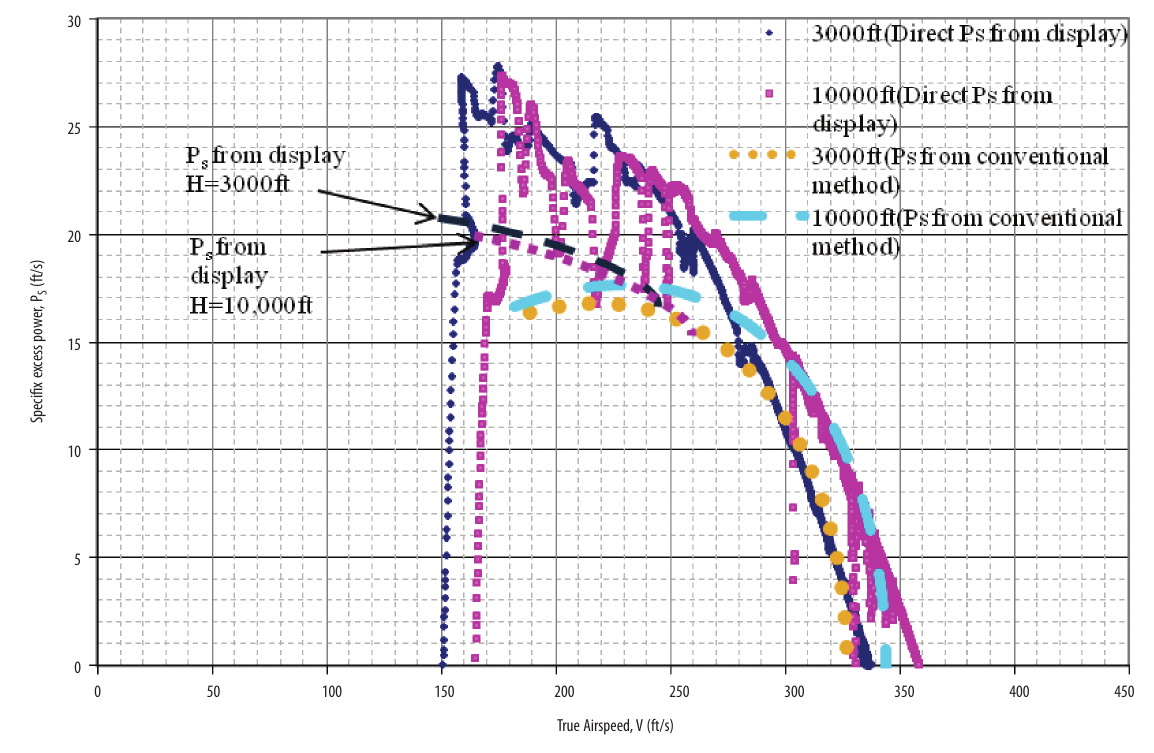
Fig. 4. Specific excess power, P S (ft/s) versus true airspeed, V (ft/s) for Piper Saratoga (conventional method and direct P S from display) (engine: Lycoming 300 hp, config.; clean config., GW: 3600lbs. method: level acceleration, maximum power setting, flight conditions: Hpo~2000 ft &10,000 ft,